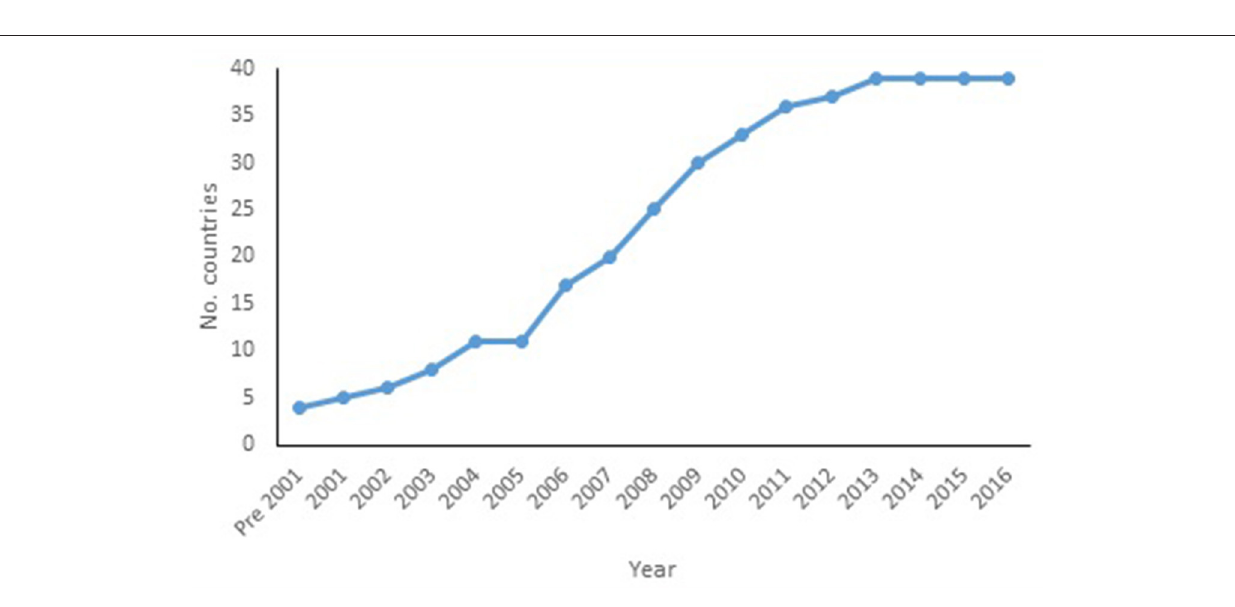
The regions of origin of the alien coccinellid species to Europe are as follows: Australian (5 species: C. montrouzieri ; H. conformis (Boisduval) R. forestieri , R. lophanthae and R. cardinalis) ; Oriental (2 species: C. nigritus , and S. parcesetosum) ; Nearctic (2 species: H. convergens and H. pantherina ); Palearctic (2 species: C. kuwanae and H. axyridis ) and Afrotropical (1 species: N. reunioni ) regions.